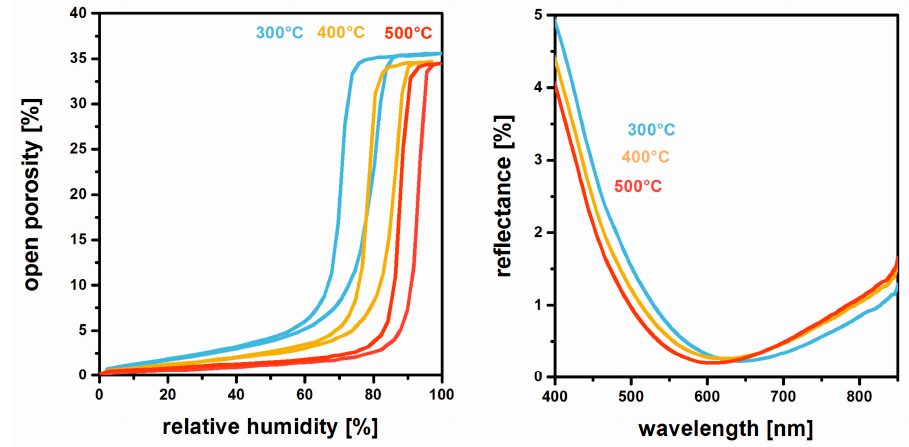
Figure 8. Water vapor sorption isotherms (EP) ( left ) and reflectance ( right ) of MgF 2 films annealed at different temperatures. Reproduced with permission from [42]. Copyright The Royal Society of Chemistry, 2012.